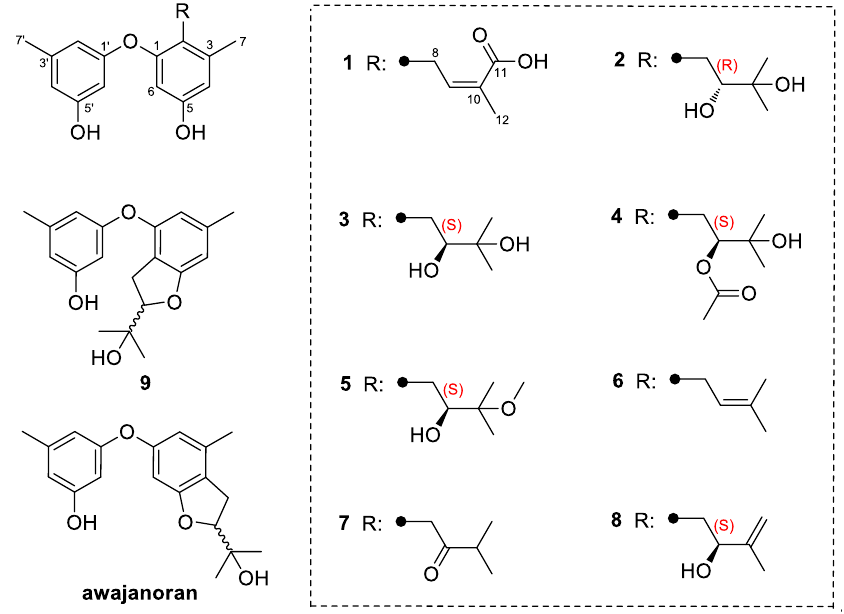
Figure 1. Structures of the isolated compounds 1 – 9 and the related compound awajanoran.